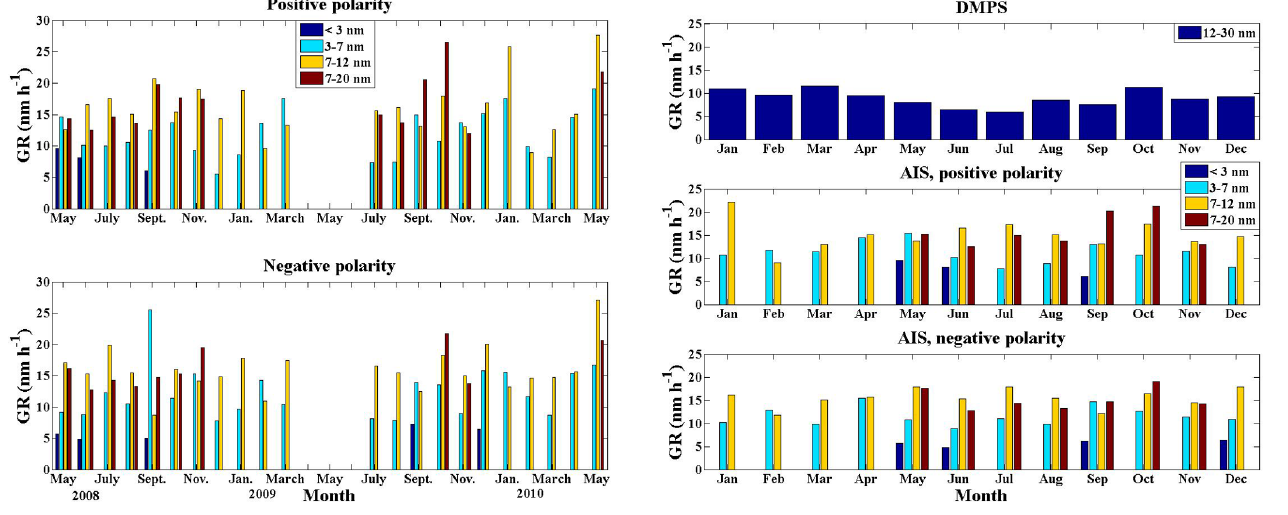
Fig. 12. Monthly median growth rates of positive and negative ions (based on the AIS data) for different size fractions indicated with different colours.